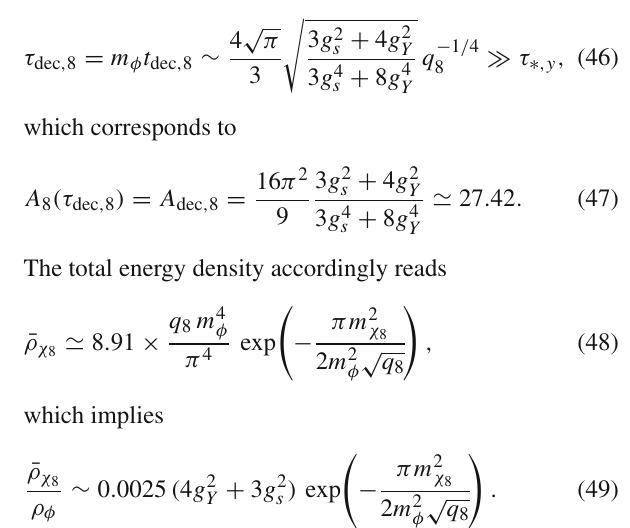
( N ) /ρ ρ 0 , where 0 is the inflaton energy φ